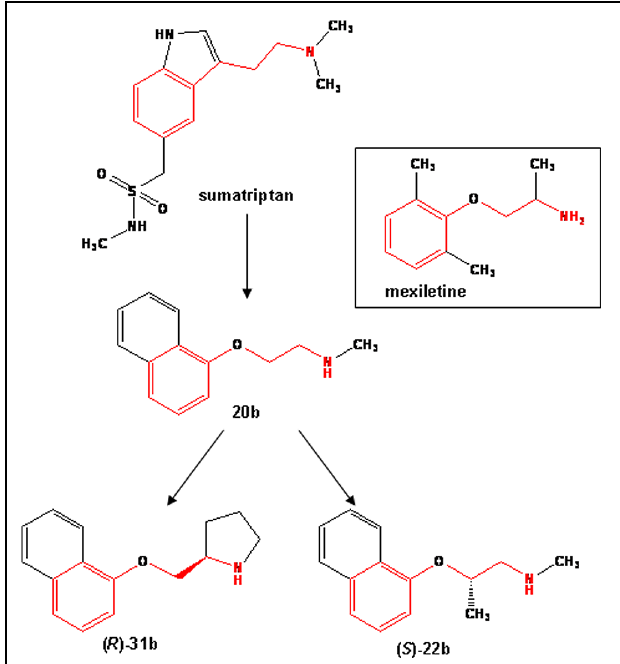
FIGURE 1 | Chemical structures of sumatriptan and its bioisosteres, compared to mexiletine. All the compounds share a common backbone shown in red, which consists of an aromatic moiety linked to a protonable amine group through an alkyl